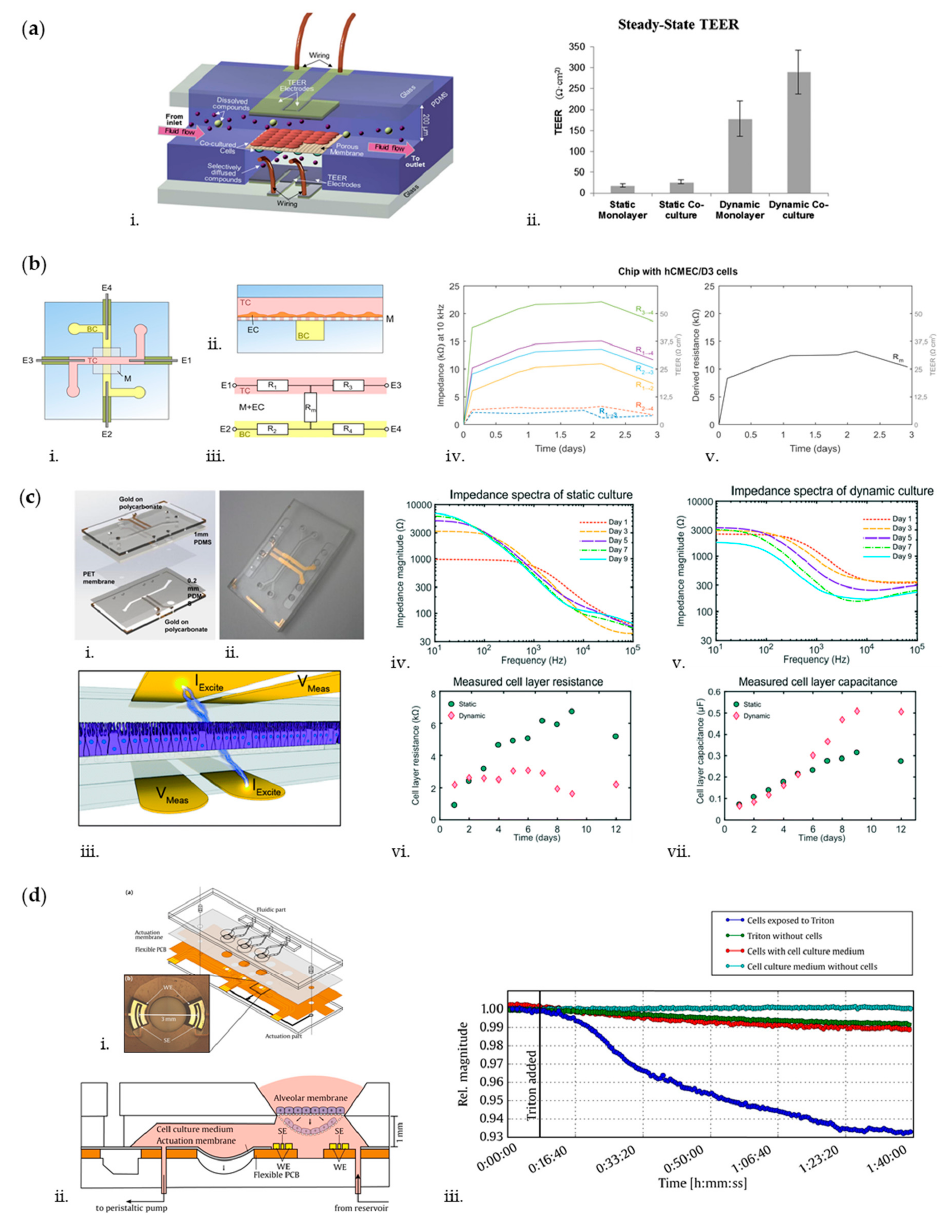
Figure 4. ( a ) 3D illustration of the microfluidic blood–brain barrier (BBB) (i), composed of two perpendicular flow channels (lumenal on top and ablumenal at the bottom), separated at the channel junction by a porous membrane. Endothelial cells and astrocytes are, respectively, cultured on the lumenal and ablumenal sides of the membrane. Steady-state transepithelial / transendothelial electrical resistance (TEER) levels (ii) show that dynamic cultures ( µ BBB) reached significantly higher TEER levels than static cultures (Transwell controls). For both systems, cocultures of endothelial cells and astrocytes developed higher TEER levels than endothelial monolayers alone. Adapted from Ref. [108] with permission from The Royal Society of Chemistry. ( b ) Schematic top view (i) and side view (ii) of the chip to perform impedance spectroscopy measurements, showing top channel (TC), membrane (M), bottom channel (BC), platinum wire electrodes (E1, E2, E3, and E4), and endothelial cells (EC). The simplified equivalent circuit of the chip (iii) show resistors representing the top channel (R 1 and R 3 ), resistors representing the bottom channel (R 2 and R 4 ), and resistor R m representing the membrane and EC barrier. Impedance and TEER measurements at 10 kHz for each electrode pair in a chip with hCMEC / D3 cells (iv) show a large variation between the electrode pairs. By calculating R m (v) the resistance of the membrane and cells is isolated. Adapted from Ref. [115] with permission from Elsevier. ( c ) Exploded CAD (Computer-Aided Design) model (i) and photograph (ii) of the TEER-chip developed by Henry et al. Gold electrodes are patterned onto polycarbonate substrates. Laser cut polydimethylsiloxane